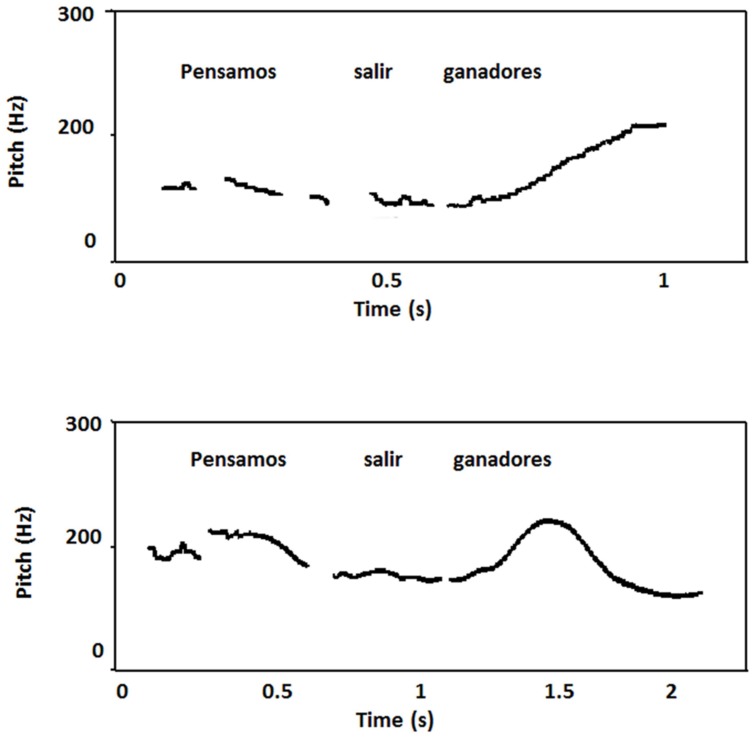
Plots of the Spanish sentence “Pensamos salir ganadores” (“We aim to win”) before the stroke (top) and 8 months later (bottom) produced by patient OM. The curve before the stroke shows a rising end contour. Note that F0 raises at the last accent syllable and continued to rise in the following unaccented ones. This seems to be a typical feature of Cordoba accent. After the stroke, there was a slow speech rate and analysis of F0 curve of the same declarative sentence showed a gradual declination. The slope of the top reference line presented an average rate of declination of about 41.4 Hz/s, similar to the value obtained in Spanish speaker from Buenos Aires (43 Hz/s).